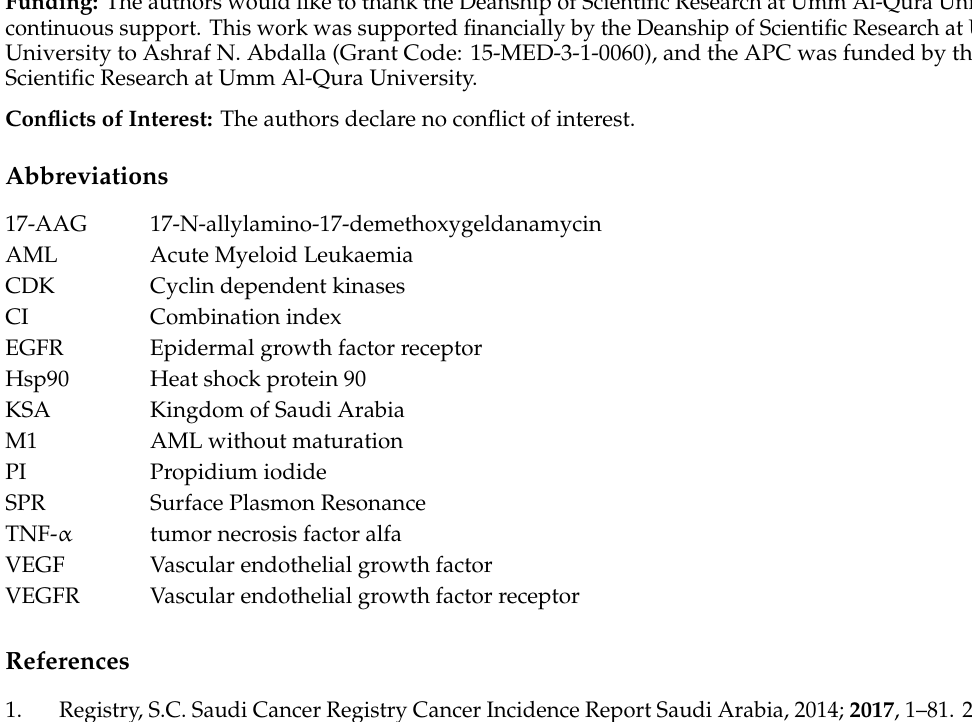
Table S1: Structure of compounds 1–5; S2: Definition of Dm, m and r values; Data files S3: Original data files for